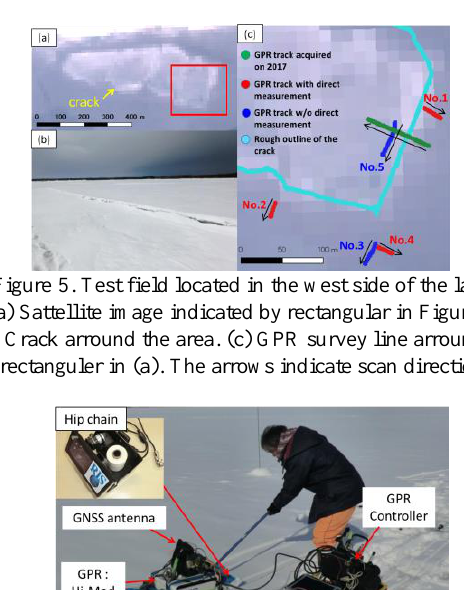
Figure 4. Sattlitte image of Lake Saroma taken by Sentinel-2, Jan. 18 th , 2018. The test field is indicated by rectanguler.